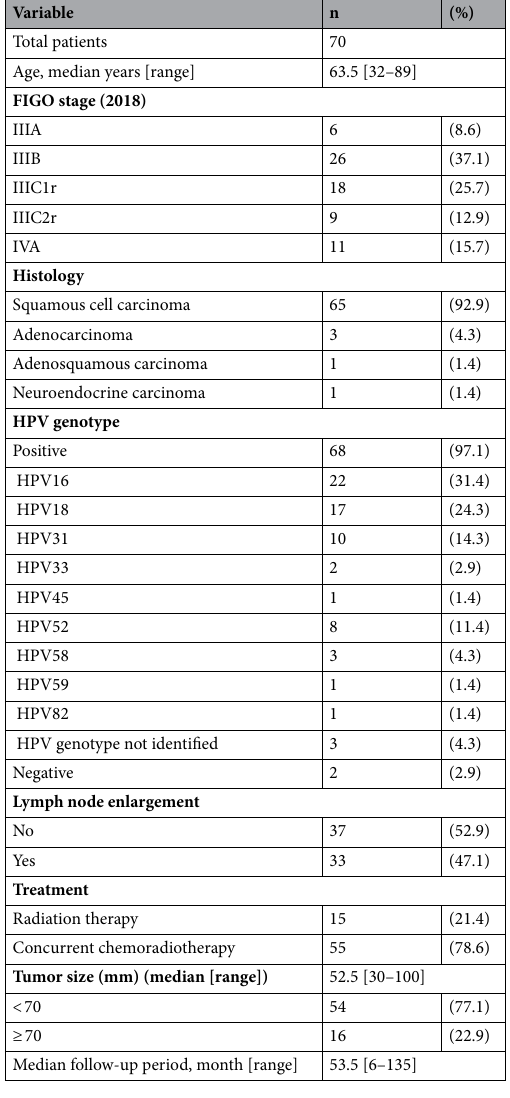
Table 1. Characteristics of locally advanced cervical cancer patients.